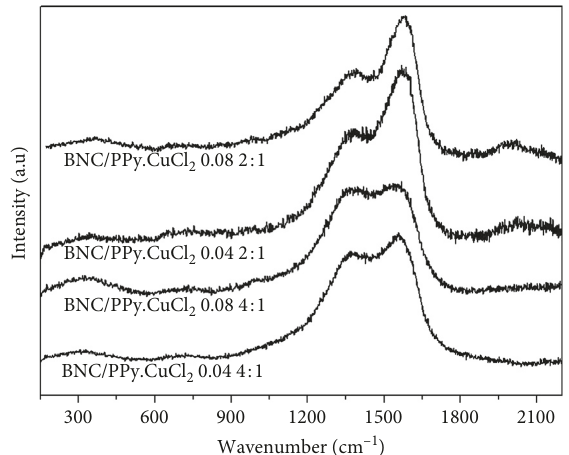
Figure 1: Raman spectra of BNC/PPy